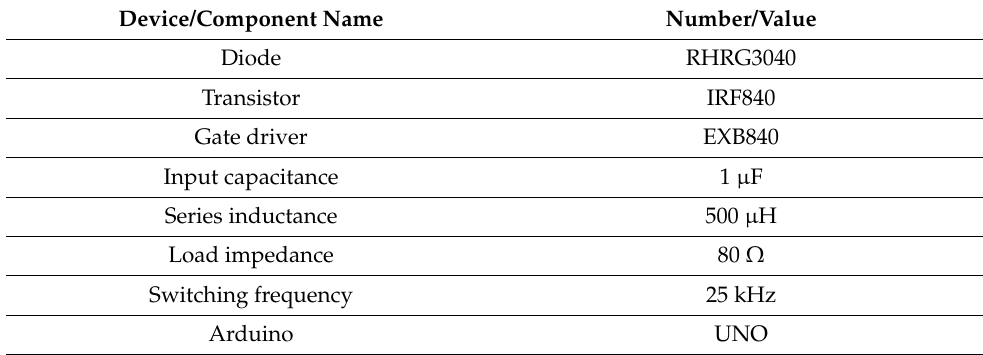
Table 4. Design parameters and components employed for real results.